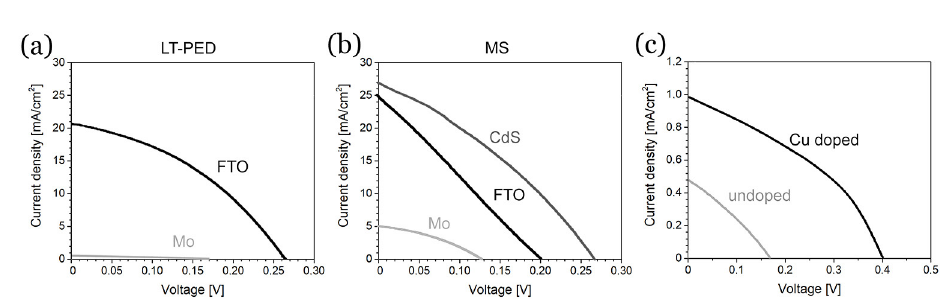
Fig. 4. – (a) J - V plot for the two cells made with Sb 2 Se 3 films deposited by LT-PED: ZnO:Al/ZnO/CdS/(Sb 2 Se 3 /Mo)/glass and ZnO:Al/ZnO/CdS/(Sb 2 Se 3 /FTO)/glass. (b) J - V plot for the three cells made with Sb 2 Se 3 films deposited by MS: ZnO:Al/ZnO/CdS/ (Sb 2 Se 3 /Mo)/glass, ZnO:Al/ZnO/CdS/(Sb 2 Se 3 /FTO)/glass, and superstrate Au/(Sb 2 Se 3 / CdS)/FTO/glass. (c) J - V plot for the undoped and the Cu-doped cells made with Sb 2 Se 3 films deposited by